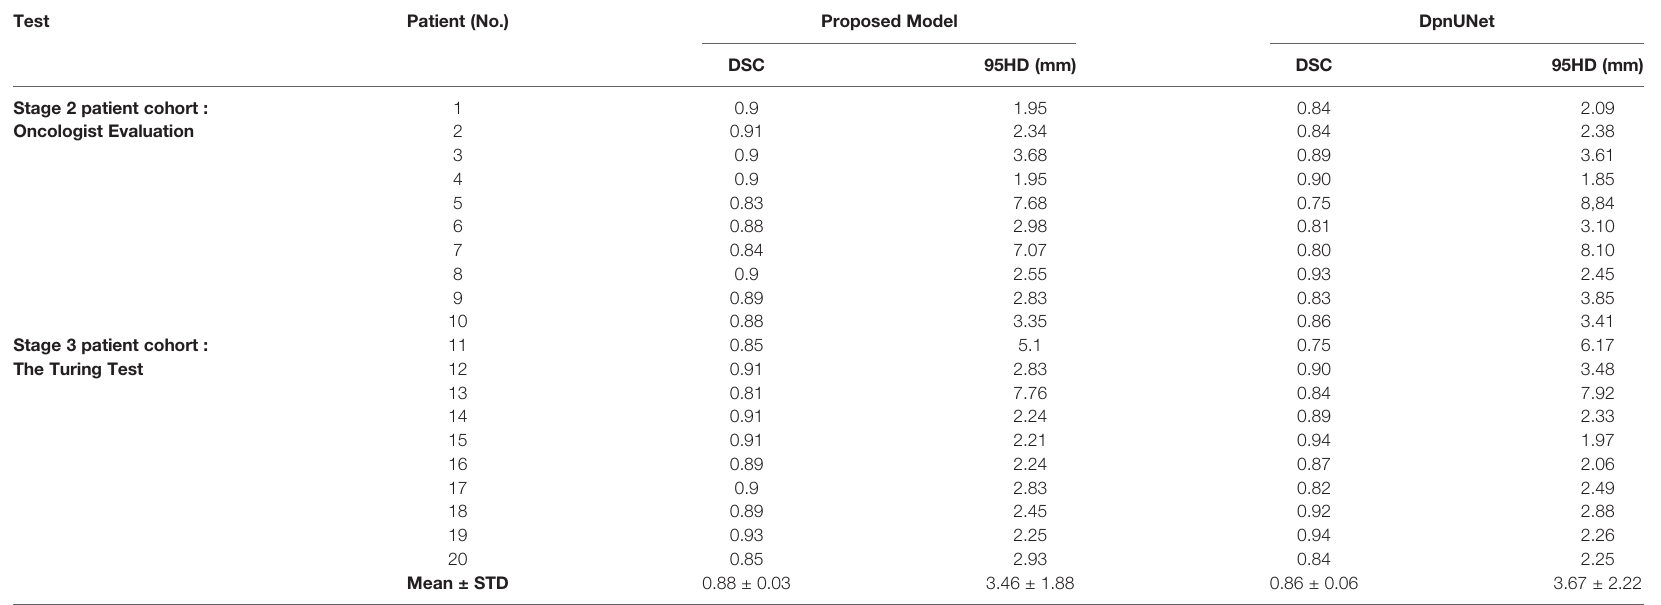
TABLE 2 | The comparison of DSC and 95HD value of our proposed model and DpnUNet.